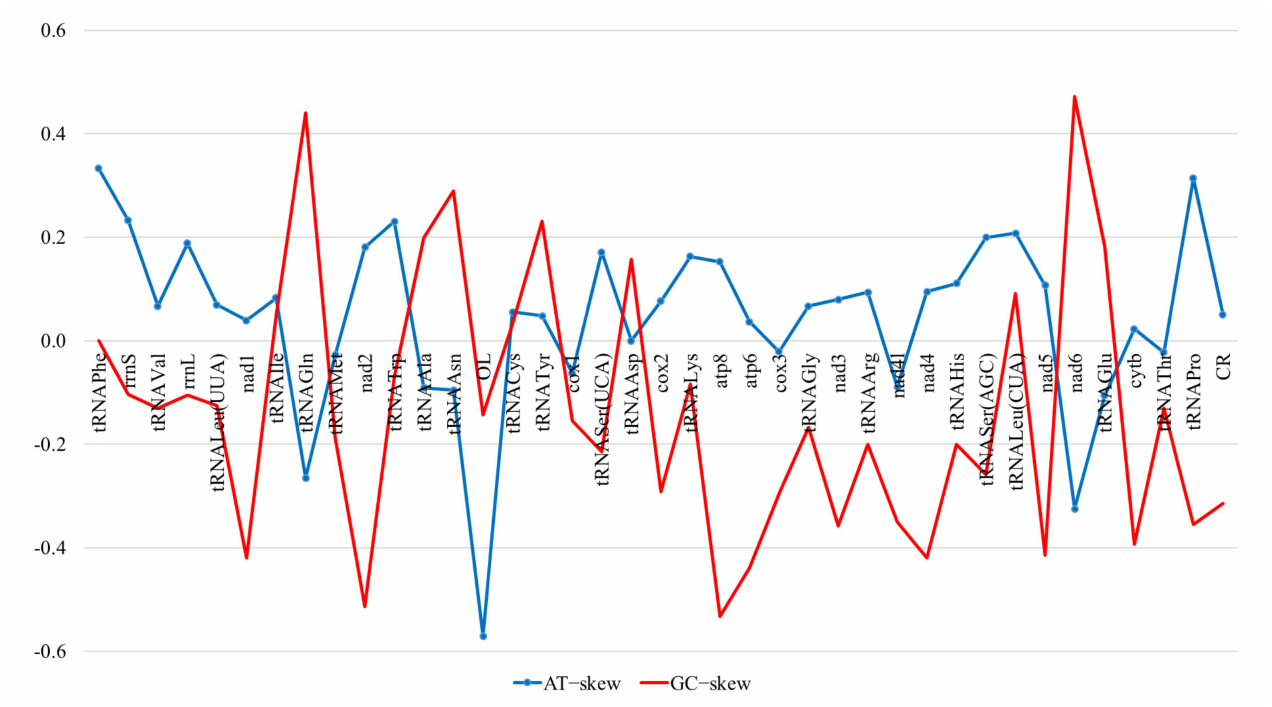
Figure 2. AT- and GC-skewness of different regions of the Mustela lutreola mitogenome (O L —light strand replication origin, CR—control